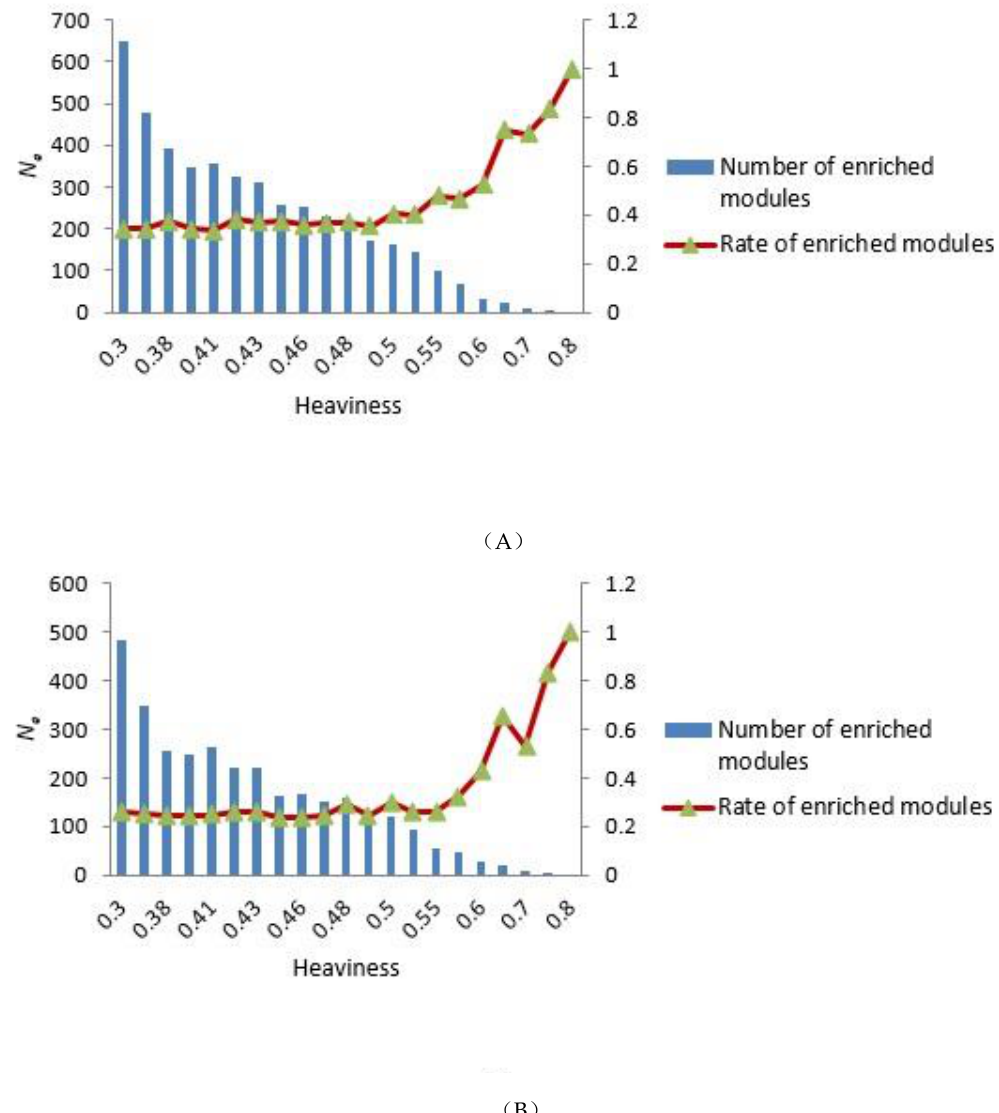
Figure 4. Distribution of the number of modules that could be significantly enriched in GO terms and KEGG pathways. ( A , B ) GO terms and KEGG pathways analyses, respectively. The blue bars represent the number of modules that were significantly enriched in GO terms ( A ) and KEGG pathways ( B ) under different heaviness values, i.e., Ne. The Y coordinate on the left corresponds to changes in Ne. The red curve with triangles indicates the ratio Rea between Ne and the total number of modules Na. The Y coordinate on the right corresponds to the value of Rea.